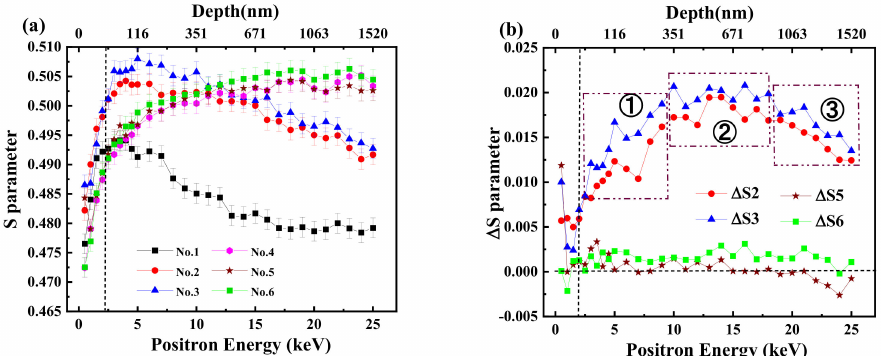
Figure 2. S - E curve ( a ) and ∆ S - E curve ( b ) of pure titanium samples after electrolytic hydrogen charging under different annealing